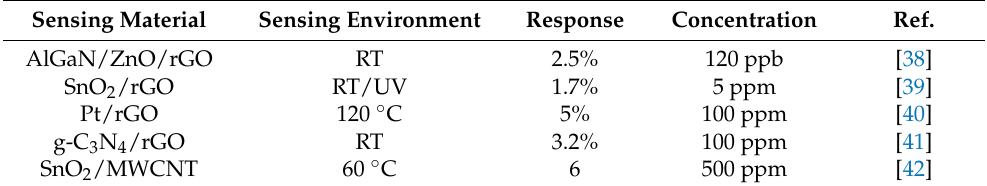
Table 1. Comparison of the SO 2 -sensing performance between the present work and previous reported